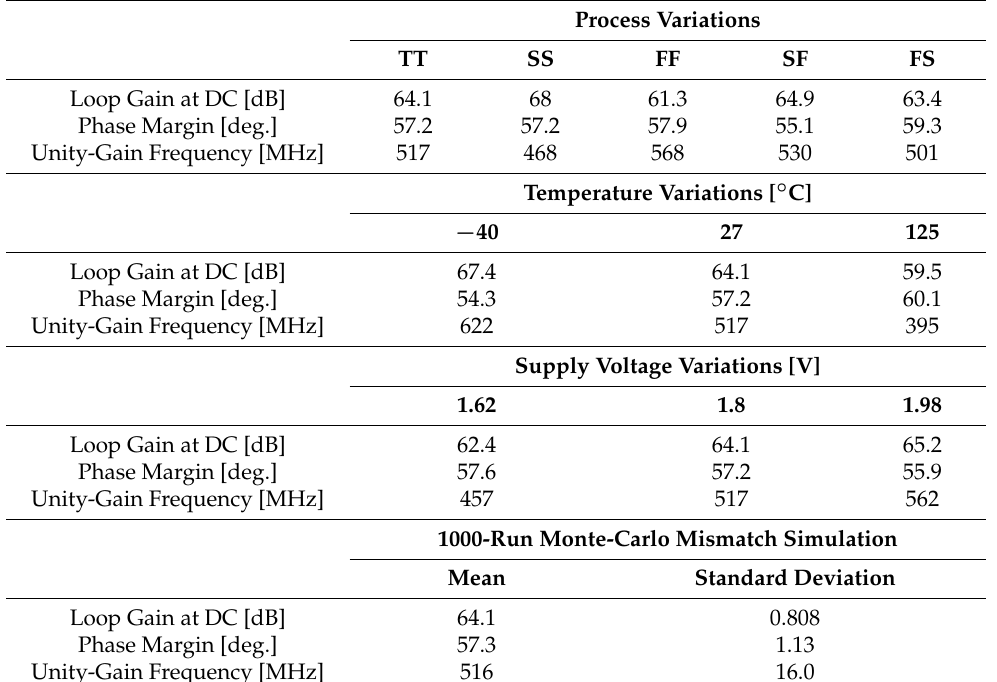
Table 1. The OPAMP’s AC Performances over PVT Variations and 1000-Run Monte-Carlo Simulation Results over Device